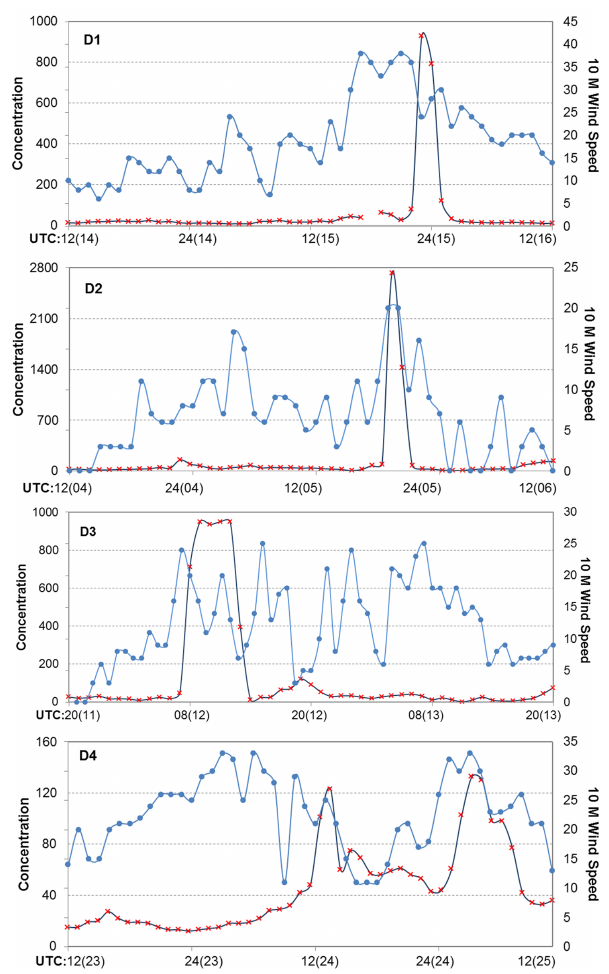
Figure 4. Variations of PM 10 hourly concentration (unit: µgm − 3 ) and surface wind speed at 10m height (unit: mph) over the dust storm period (48h surrounding the peak of the dust storm) in the dust-impacted region. Data are from EPA AQS. D1: records on site 480290053 used; D2: records on site 4010 used; D3: records on site 60710306 used; D4: records on site 480290053